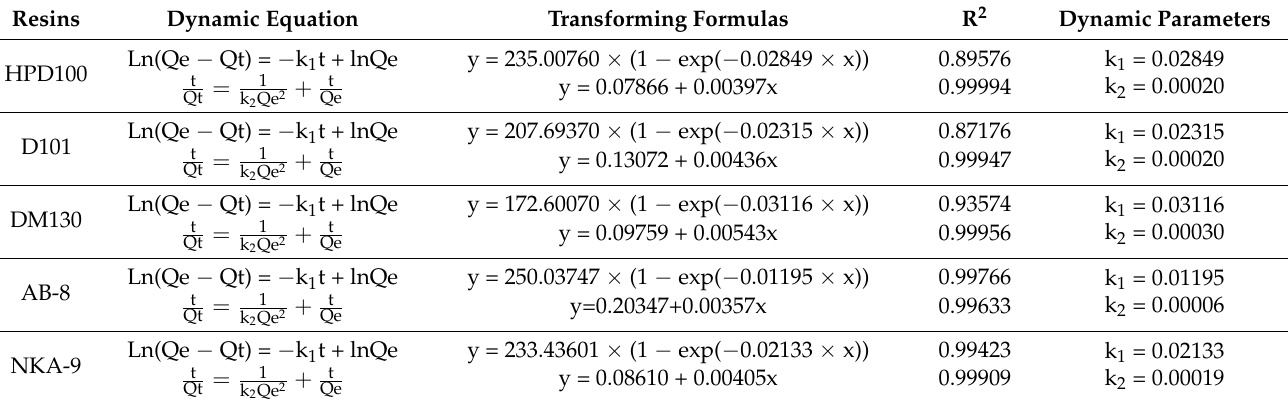
Table 2. Pseudo -first-order and pseudo -second-order model equations and dynamic parameters.